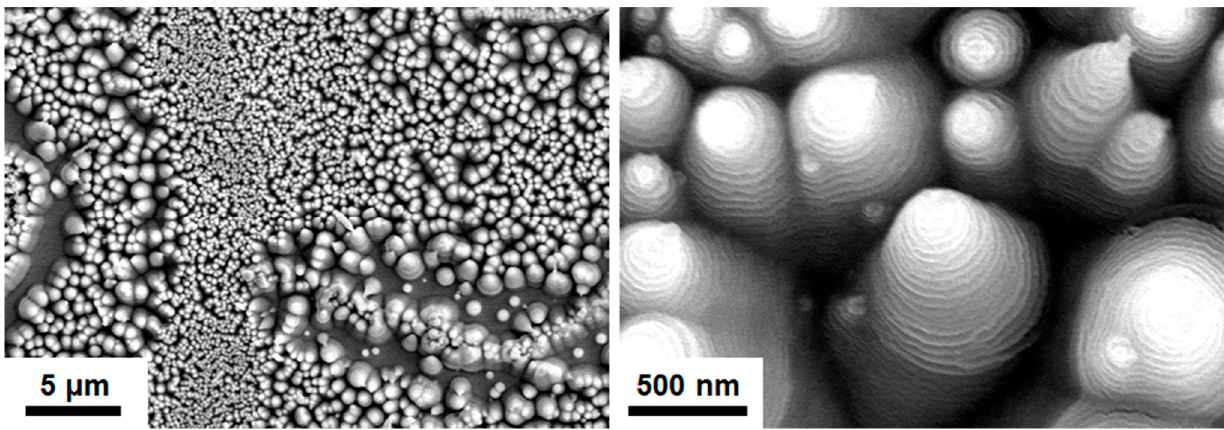
Figure 12. SEM images of the T1 samples annealed at 600 °C in 1% O 2 –Ar for 8 h.